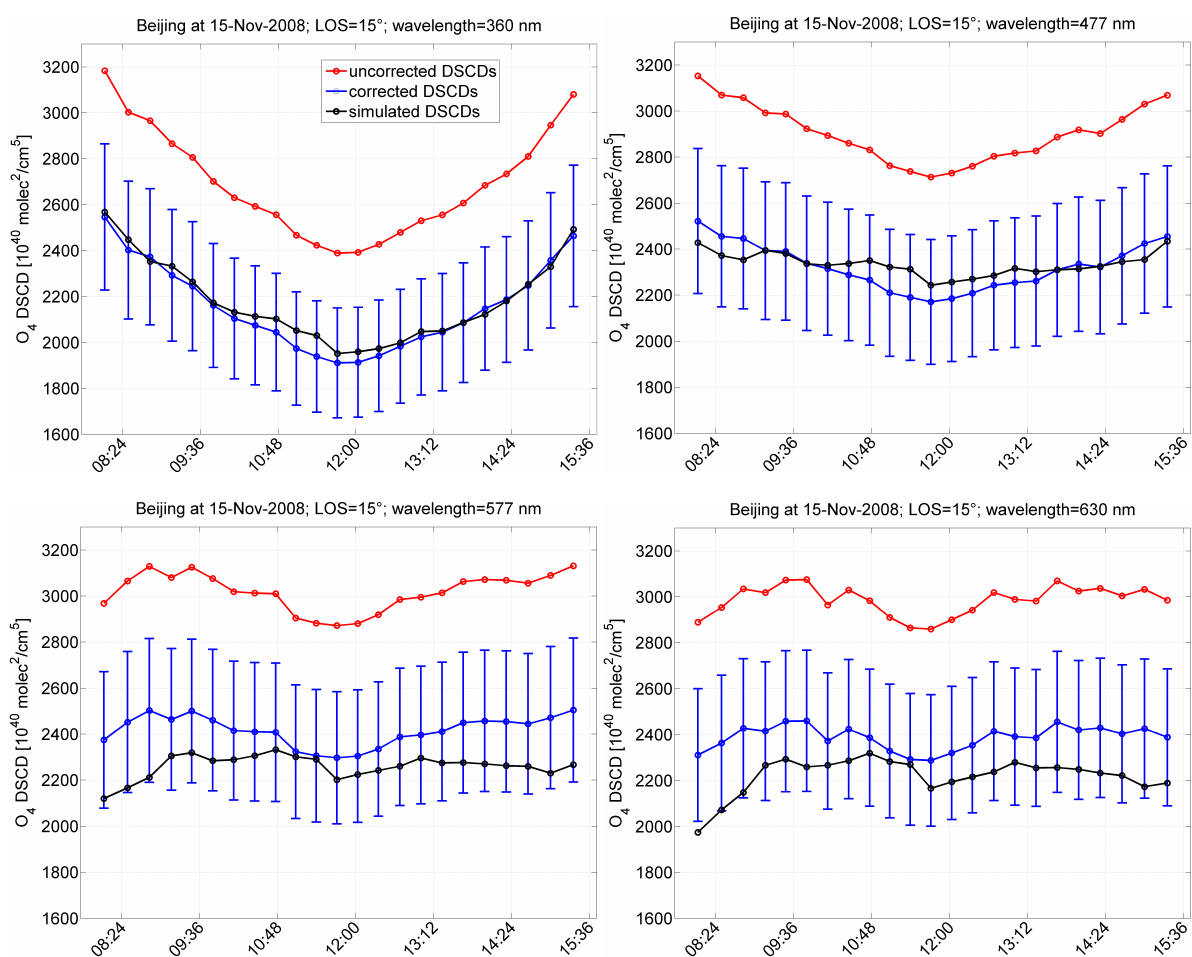
Fig. 4. The diurnal variation of the simulated O 4 DSCDs and the uncorrected and corrected O 4 DSCDs for 15 ◦ elevation on 15 November 2010 in